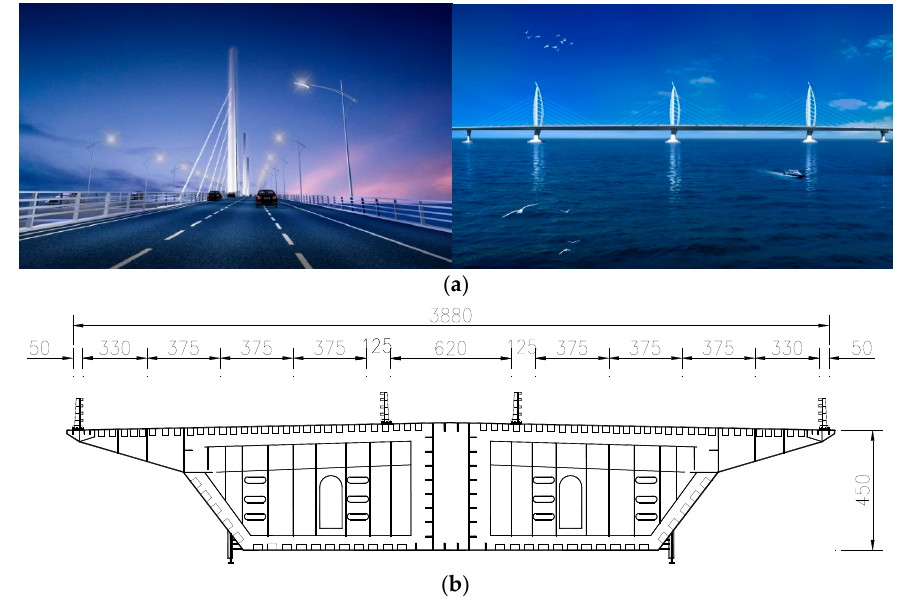
Figure 1. The Jianghai Channel Bridge: ( a ) overview; and ( b ) dimensions of the bridge deck (cm).